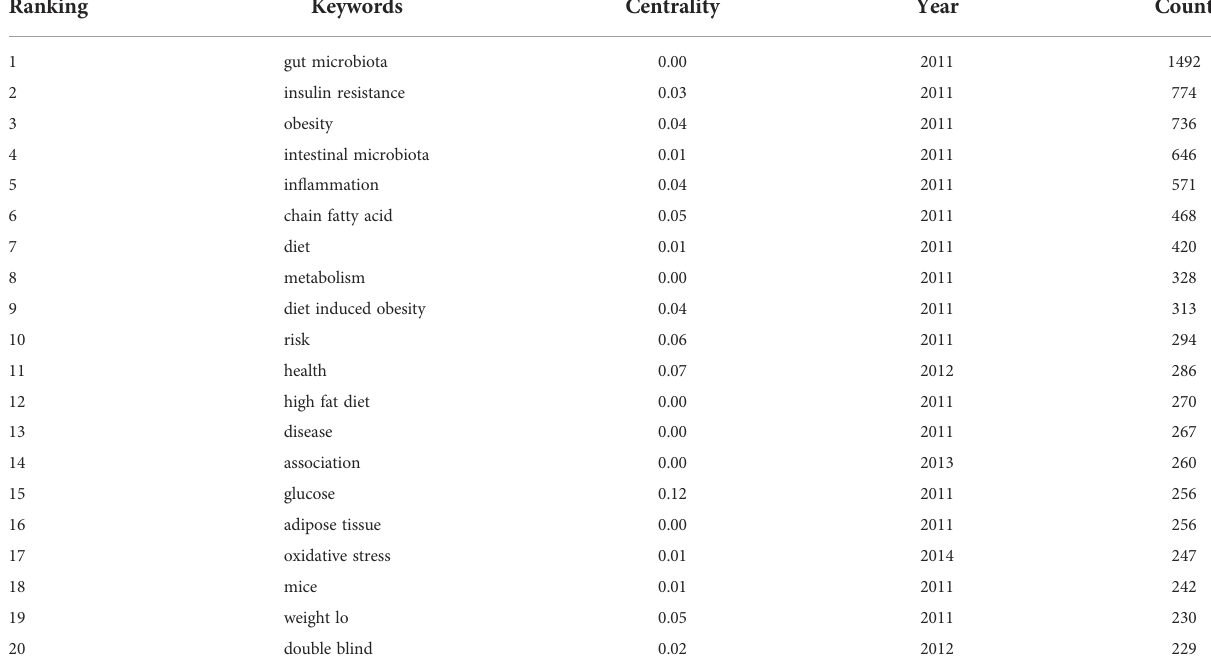
TABLE 4 The 20 keywords with the highest frequency.